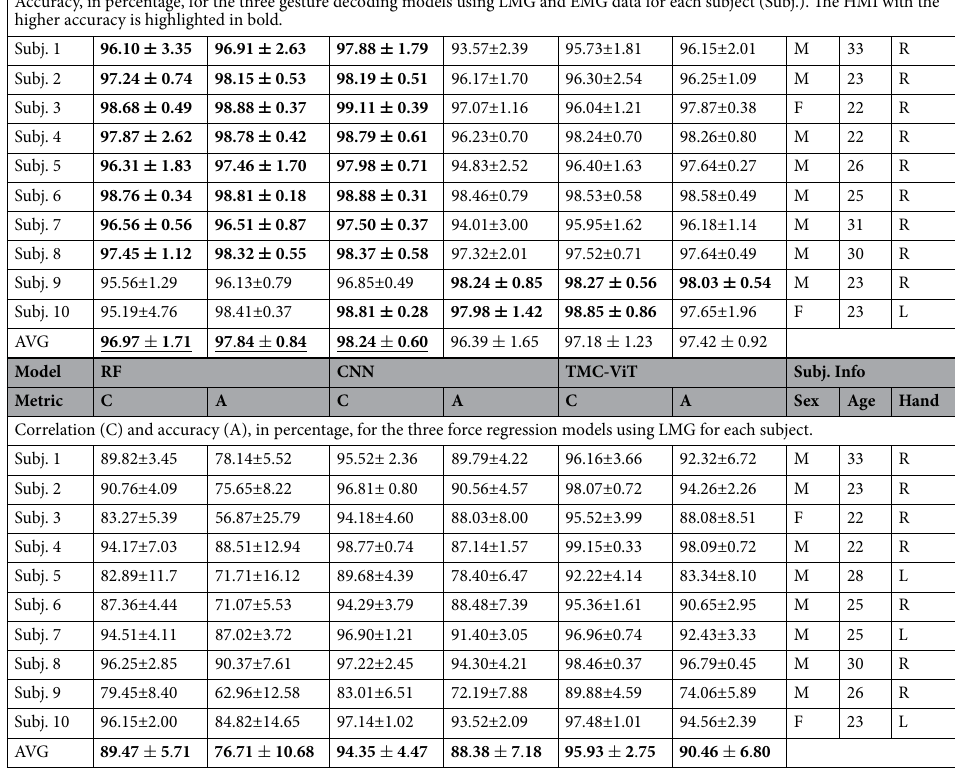
Table 2. Gesture decoding and force estimation results.